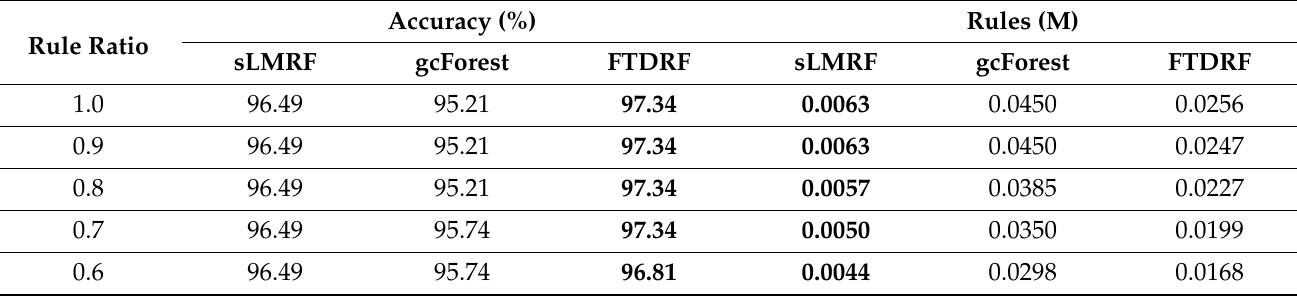
Table 4. Comparison of accuracy and numbers of rules among three DRF models according to changes in rule elimination using the WDBC dataset. The rule ratio 1.0 of sLMRF is the same as that of LMRF. Rule